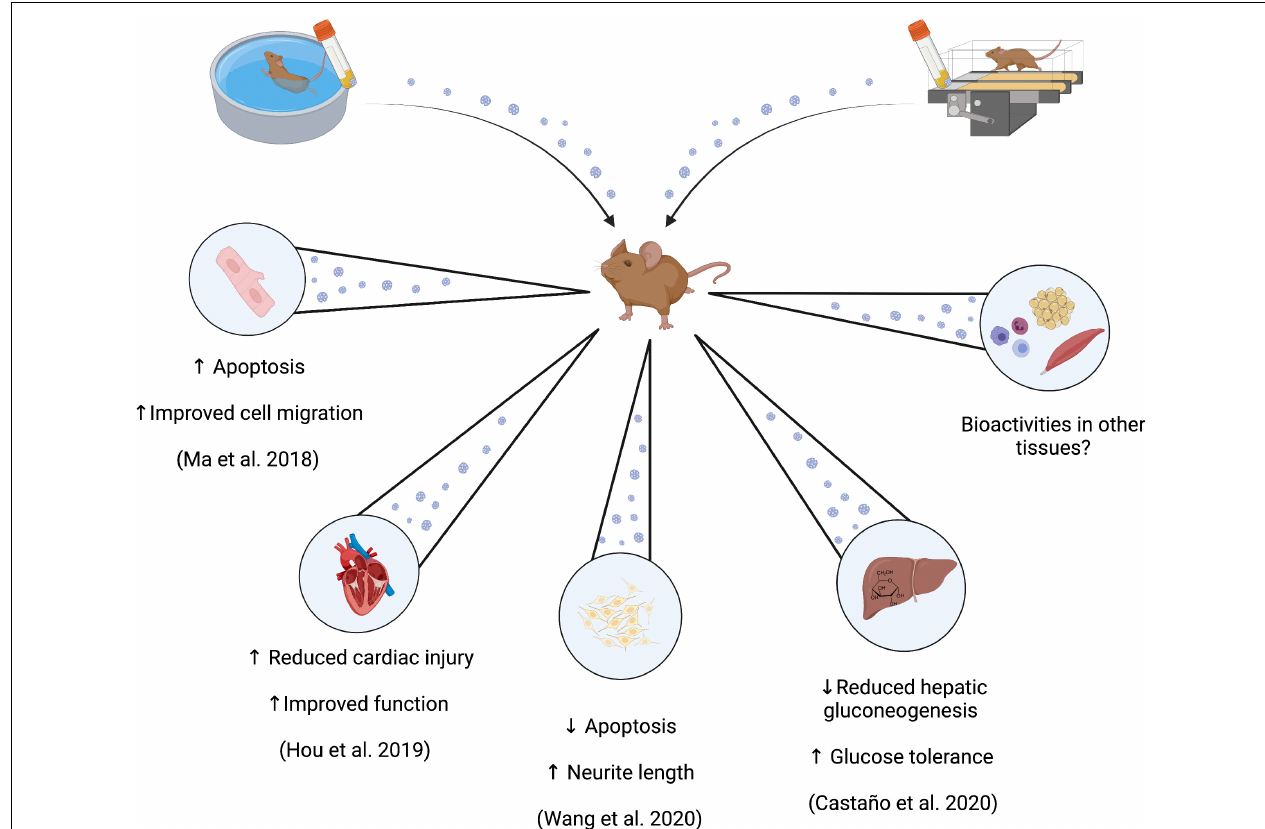
FIGURE 2 | Potential bioactivities of circulating small EVs derived from exercise-trained rodents. Administration of circulating small EVs prepared from blood samples from exercise-trained rodents are identified to induce effects both in vivo and ex vivo that may be associated with health primarily as enhanced glucose tolerance ( in vivo), and enhanced recovery from ischemic injury ( in vivo and in vitro ).